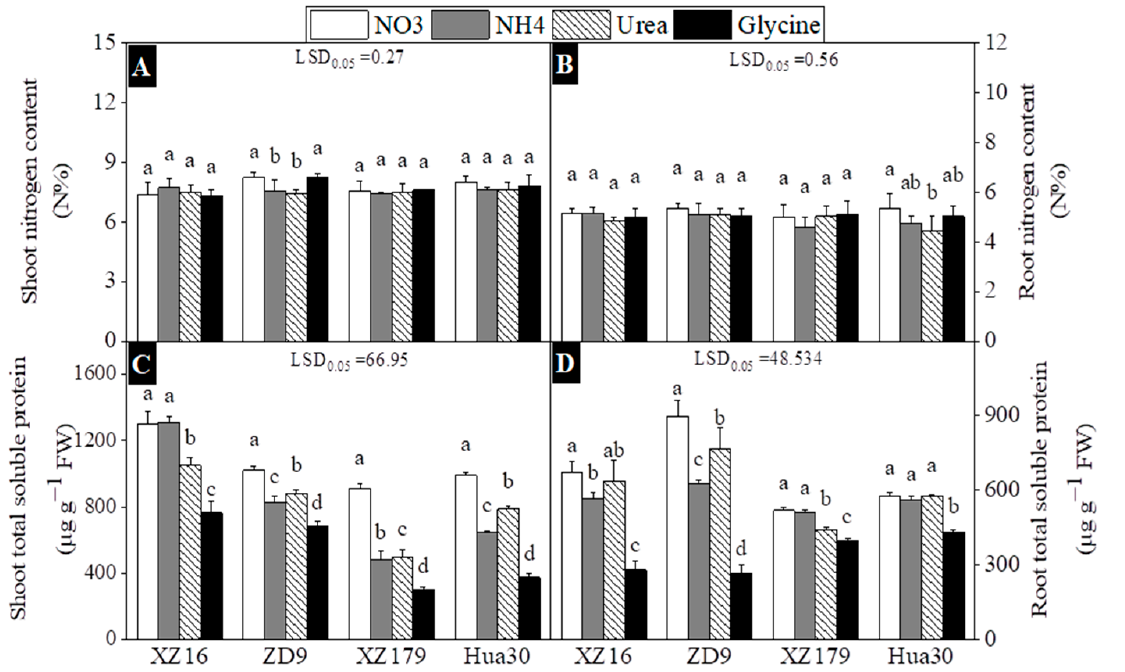
Figure 5. Effects of different nitrogen forms on nitrogen content ( A , B ) at day 30 after treatment (stage 4 and day 44 on BBCH scale) and total soluble protein contents ( C , D ) at day 29 after treatment (stage 4 and day 43 on BBCH scale) of four barley genotypes. Values are expressed as mean ± SD ( n = 4). Significant difference ( p < 0.05) between treatments is indicated by different letters. LSD.05 values in the figures are for the comparison between genotypes.